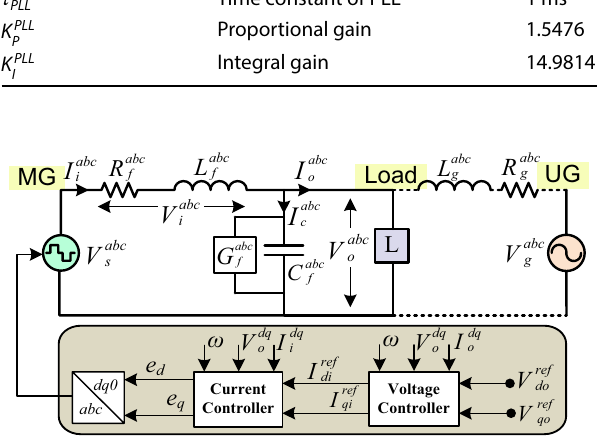
Fig. 4 Simplified circuit representation of the RESM plant